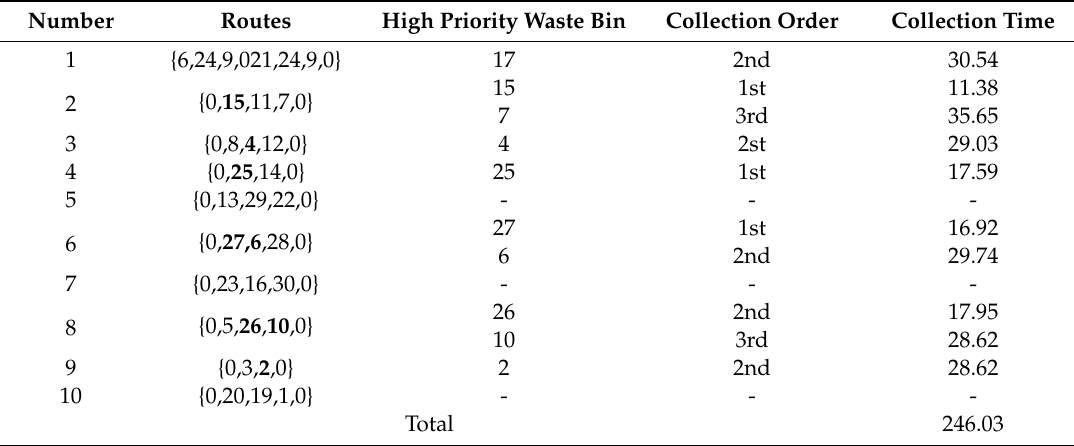
Table 12. Detailed route information under conventional scenario (CS).